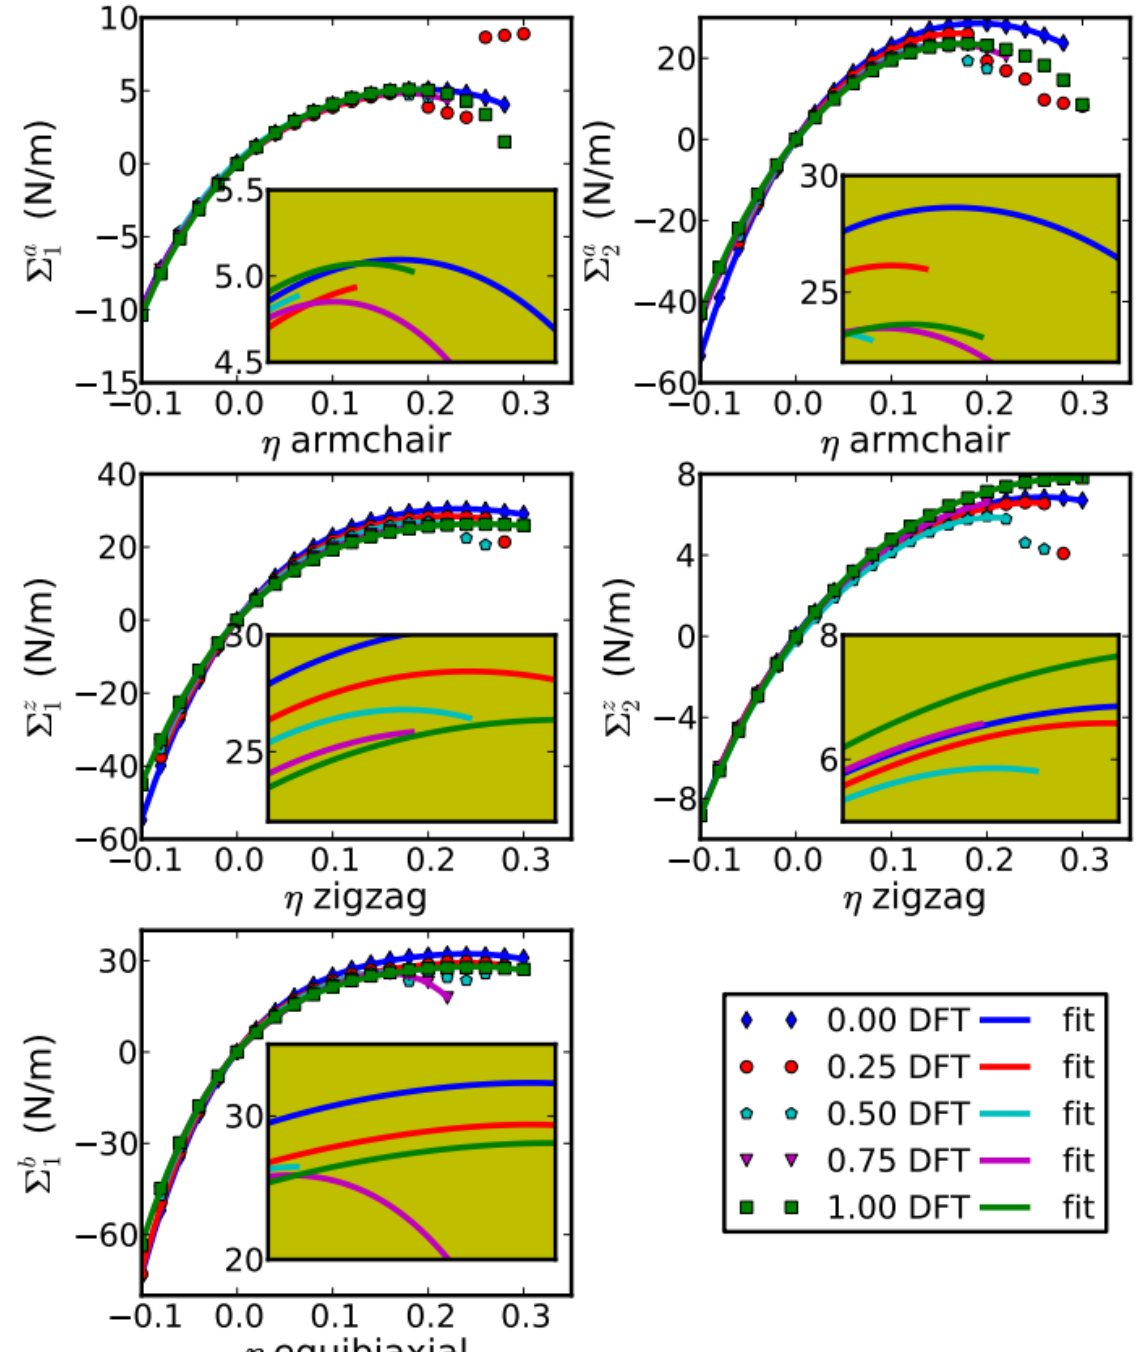
Figure 4. Stress – strain responses for uniaxial strain in armchair and zigzag directions, and equibi- Figure 4. Stress–strain responses for uniaxial strain in armchair and zigzag directions, and axial strains as a function of g -BN concentrations C BN . Σ 1 (Σ 2 ) denotes the x ( y ) component of stress. “fit” stands for the fitting of DFT calculations (“DFT”) t o continuum elastic theory.